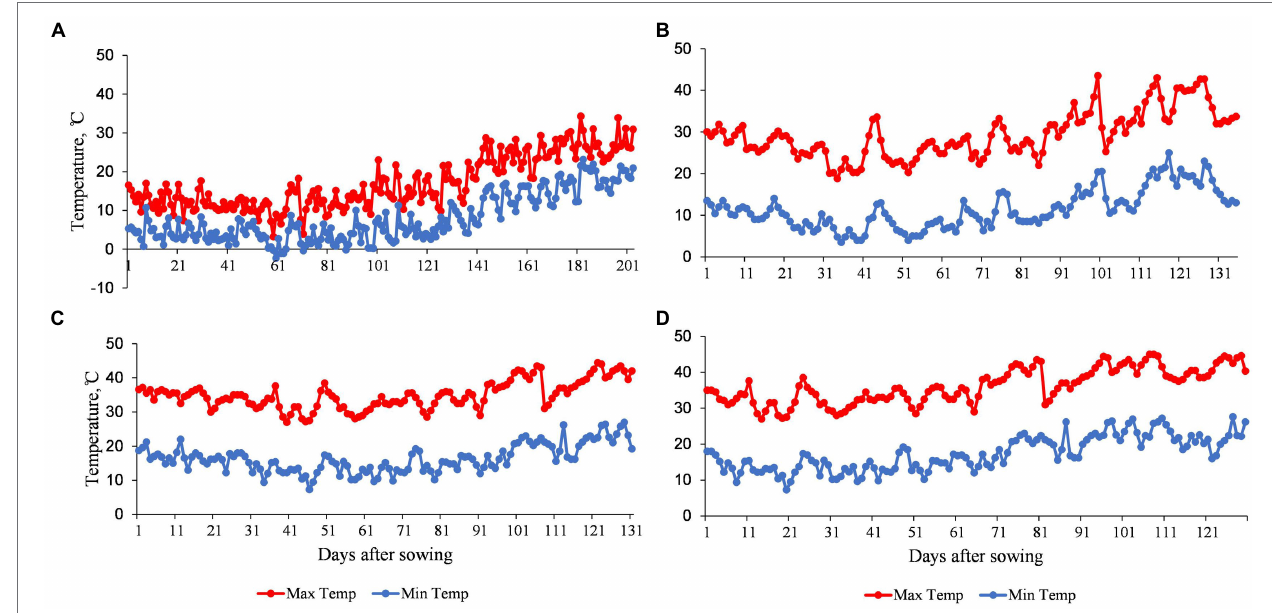
FIGURE 1 | Daily maximum and minimum air temperatures of the four environments used to evaluate the multiple derivative lines (MDLs): (A) Tottori (TOT); (B) Dongola (DON); (C) Wad Medani first sowing date (MED/SD1); and (D) Wad Medani second sowing date (MED/SD2).